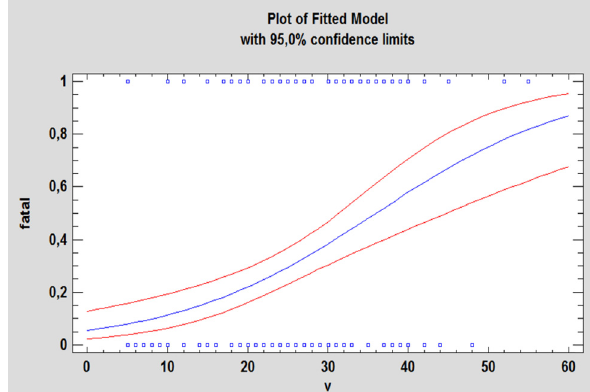
Figure 2: The fatality risk as a function of impact speed for pedes - trian hit by the front of a tram.